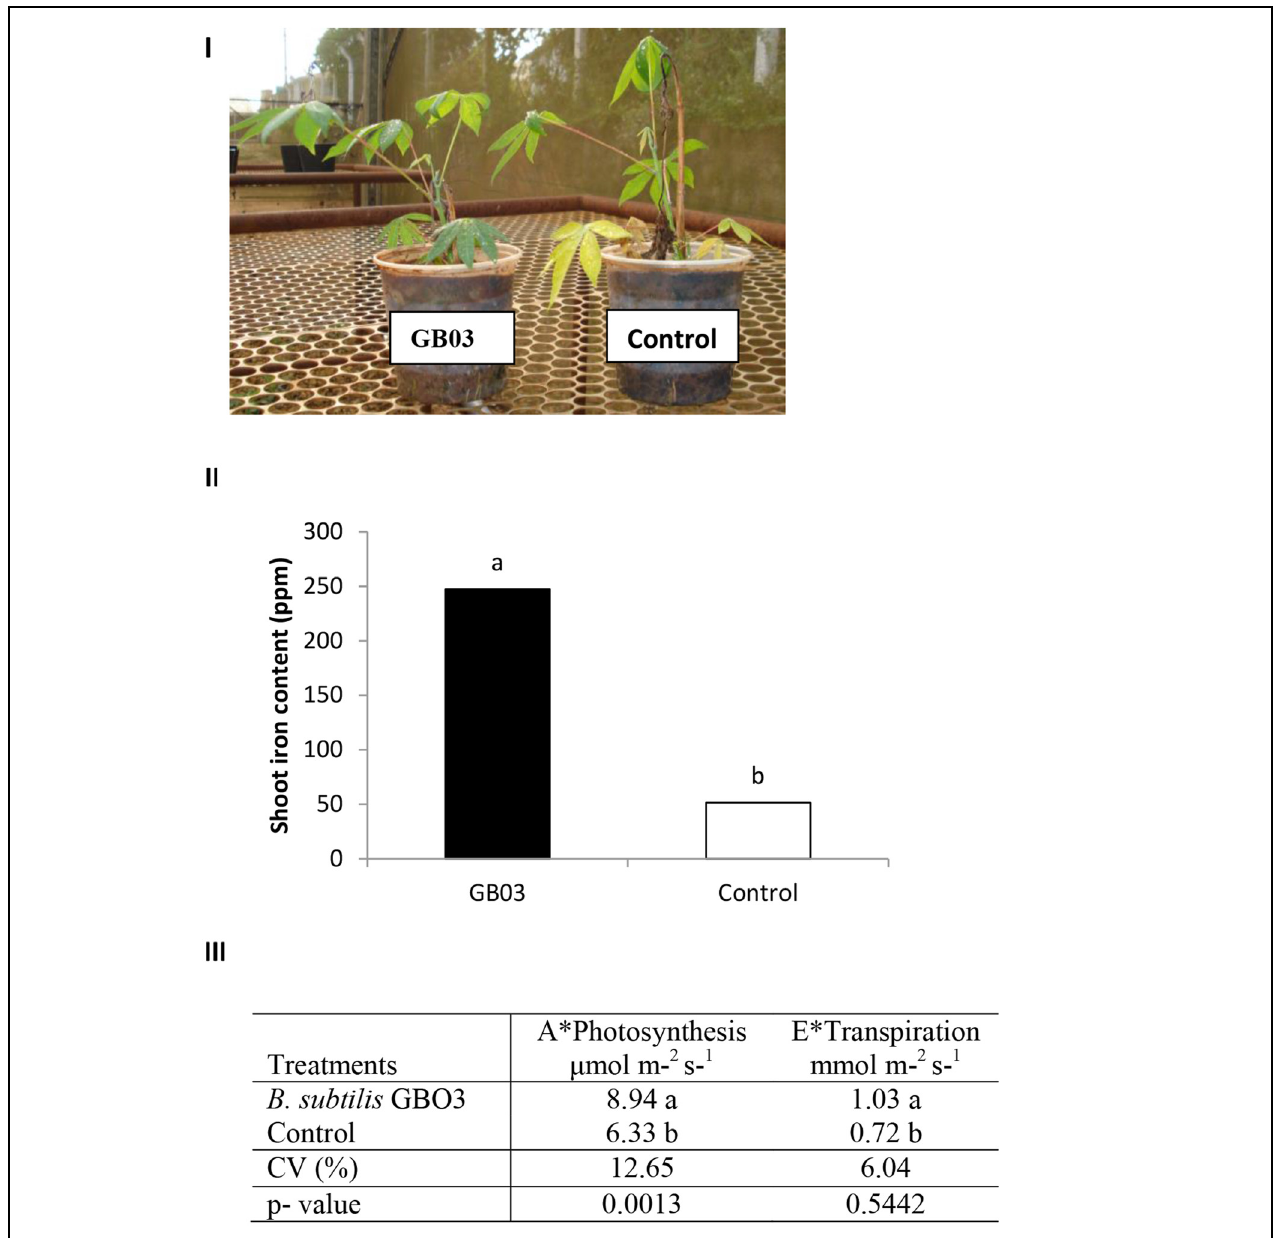
FIGURE 3 | Bacillus subtilis GB03-mediated iron accumulation and changes in photosynthesis and transpiration compared to the water-control. (I) Cassava plants ( M. esculenta ) used (II) mean ( n = 4)